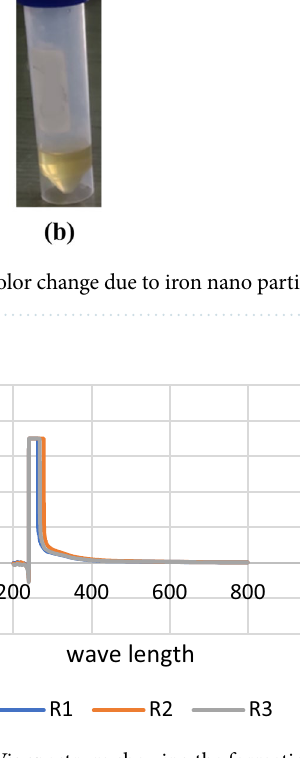
Figure 4. UV–Vis spectrum showing the formation of the nano iron characteristic beak in replicated samples.